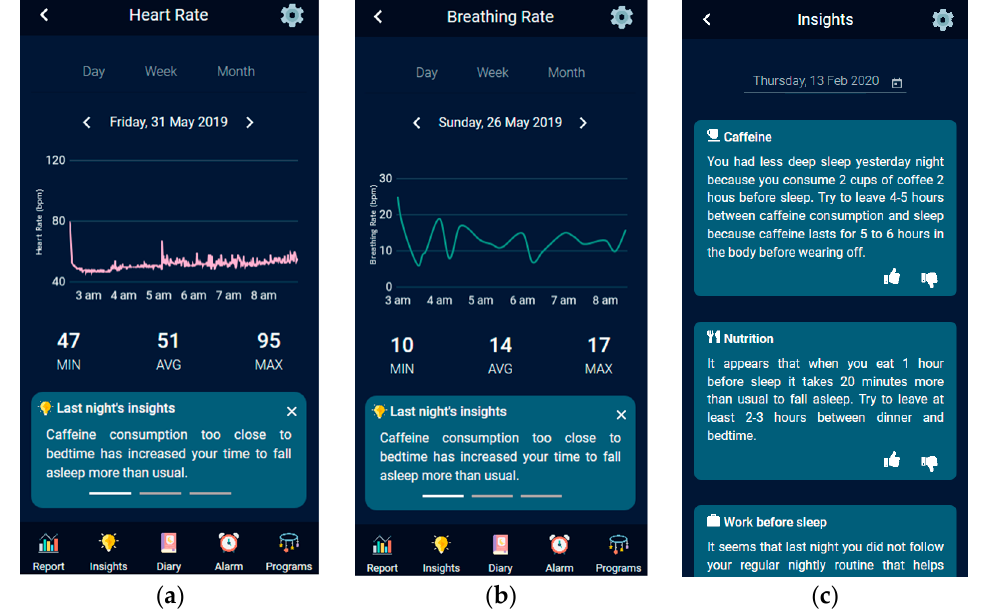
( c ) Figure 15. ( a ) Diary, ( b ) Pre-sleep Diary, and ( c ) Post-sleep Diary. Finally, the pervasive relaxation player of CaLmi (Section 6.3) became part of the HypnOS system, since it provides the means to create an optimal sleep environment (Sec- tion 2.6.2), and offer pervasive relaxation programs (Section 2.6.3) that are appropriate for helping people fall asleep faster. In more detail, exploiting the ambient facilities of the Intelligent Bedroom, the player has the ability to project multimedia to the surroundWall (Figure 1b), play sound and music from the room’s speakers, adjust a room’s lighting con- ditions, release a pleasant odor into the room using a scent diffuser, etc. 7.4. Evaluation A small-scale formative user-based evaluation experiment was conducted in order to assess the complete functionality of the mobile application of HypnOS and uncover user’s opinion regarding the overall concept of HypnOS, using observation and questionnaires as the main methods. The experiment was conducted in the bedroom simulation space of